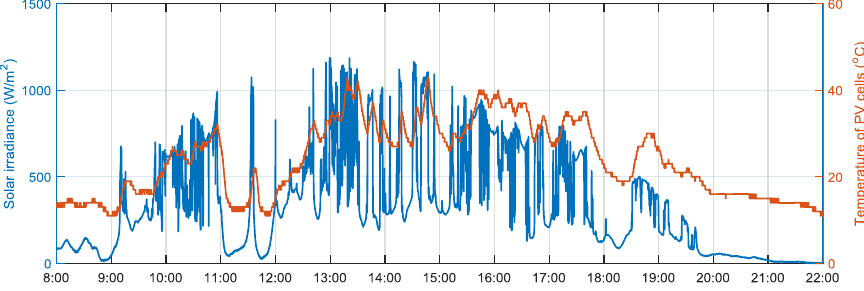
Figure 6. Solar irradiance and PV cell temperature.